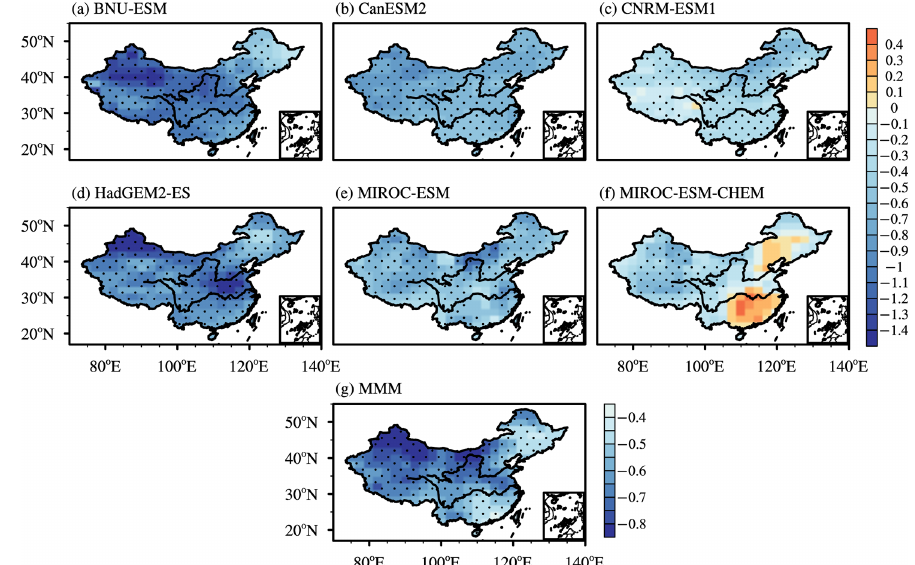
Figure 6. Spatial patterns of surface air temperature differences (units in ◦ C) between G4 and RCP4.5 over China during the period of 2030– 2069 in summer for (a–f) individual models and (g) the multi-model mean. The dots in panels (a)–(f) indicate areas which are statistically significant at the 90% confidence level. The dots in panel (g) indicate areas where at least two-thirds of the models share the same sign with the multi-model